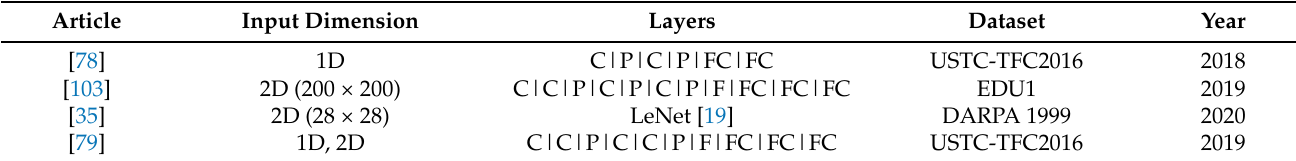
Table 3. The summary of articles that are in the raw traffic transformation